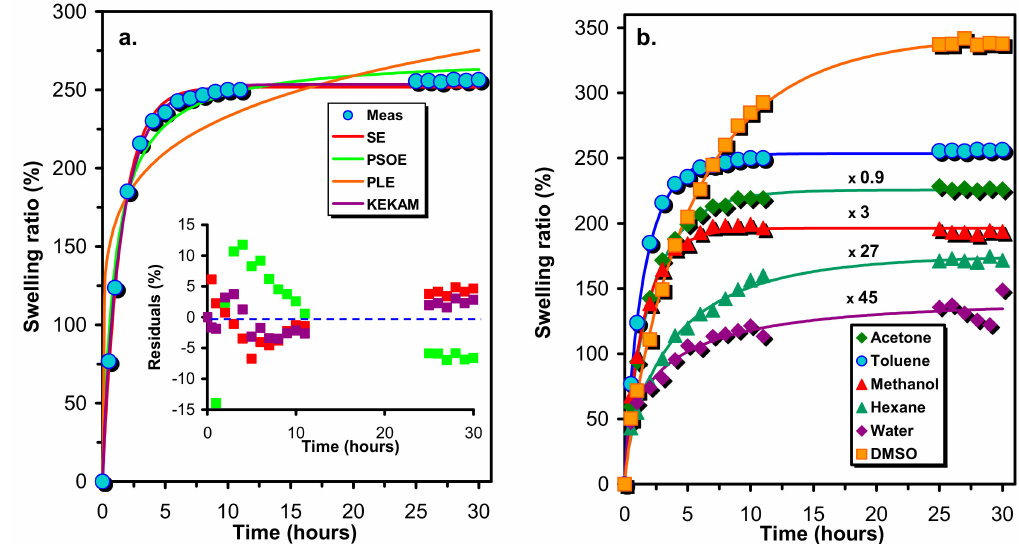
Figure 3. Variation of the swelling ratios with time for the sample SPUR-4 and fitting of the di ff erent models to the experimental data (solid lines) (a) and the dependence of the swelling ratio on the time together with the curves fitted by the streched exponential function (solid lines) (b). The inset in Figure 4a. shows the residuals as the di ff erence between the experimental and the fitted data by the various models. The fitted parameters can be found in the Supplementary Materials (Table S1).